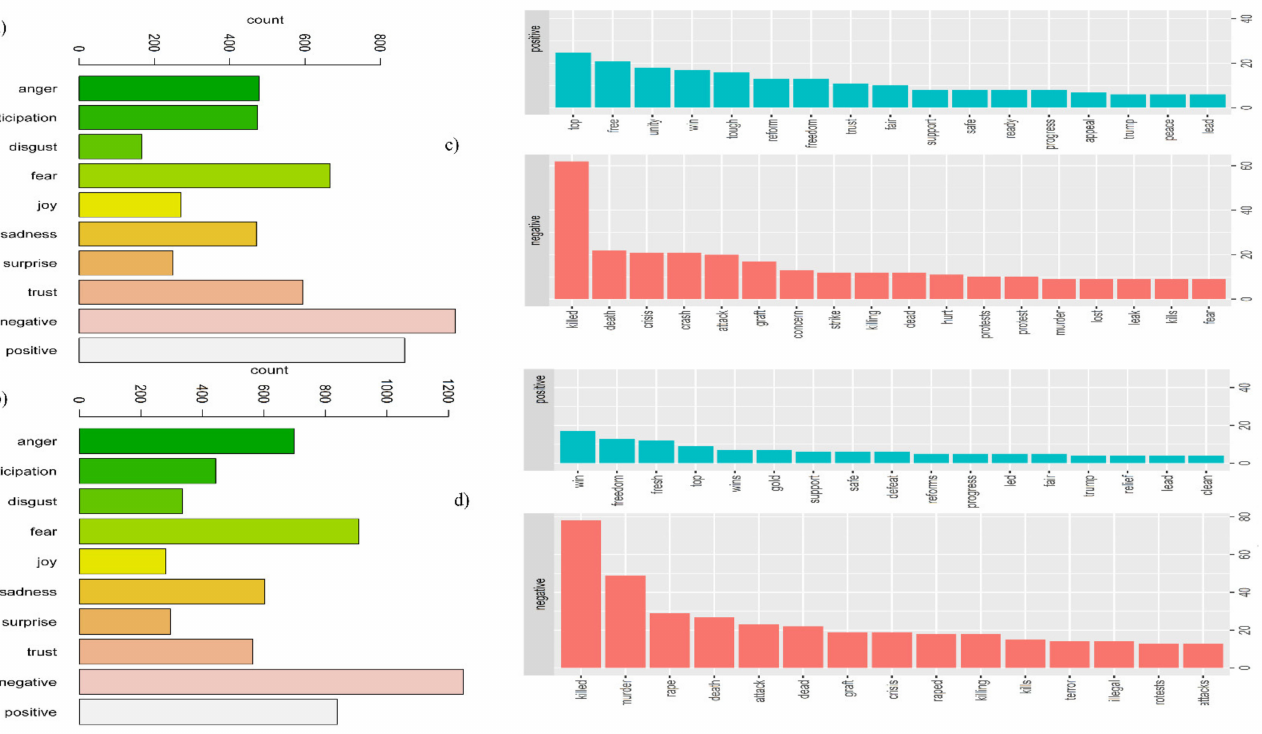
Figure 5. Sentiment Analysis in emotions (left panel, 2019 ( a ) and 2018 ( b )) and words of sentiment (right panel, 2019 ( c ) and 2018 ( d )).